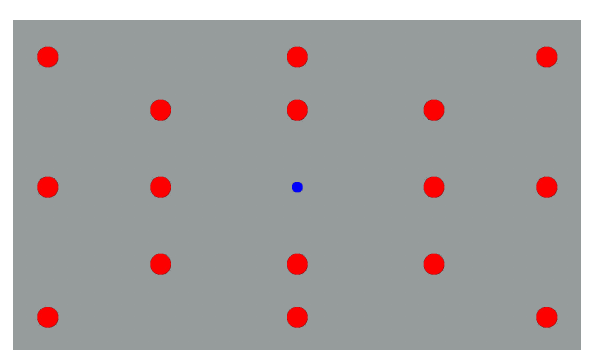
Figure 3. Illustration of screen target positions for movements of mouse cursor. Home target is shown in blue, and all endpoint targets in